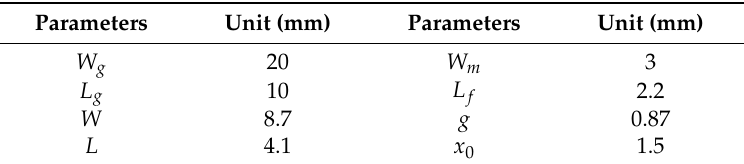
Figure 4. ( a ) Fabricated sensor; ( b ) Experiment setup.